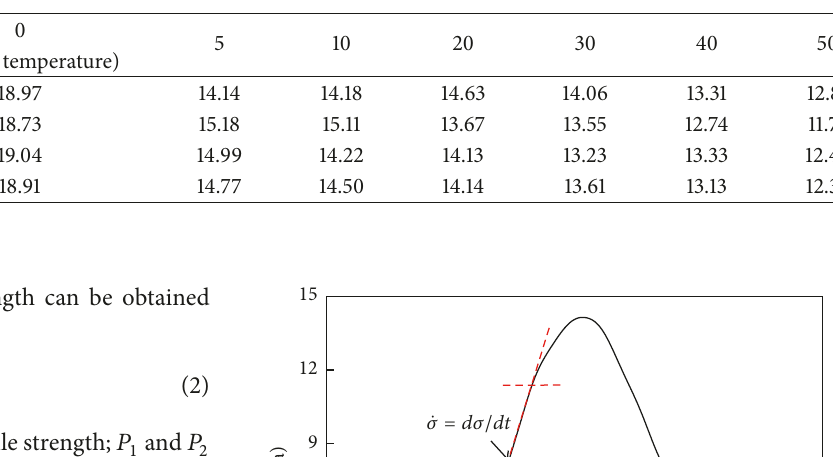
Table 3: Dynamic tensile strength of sandstone under different heating rates.